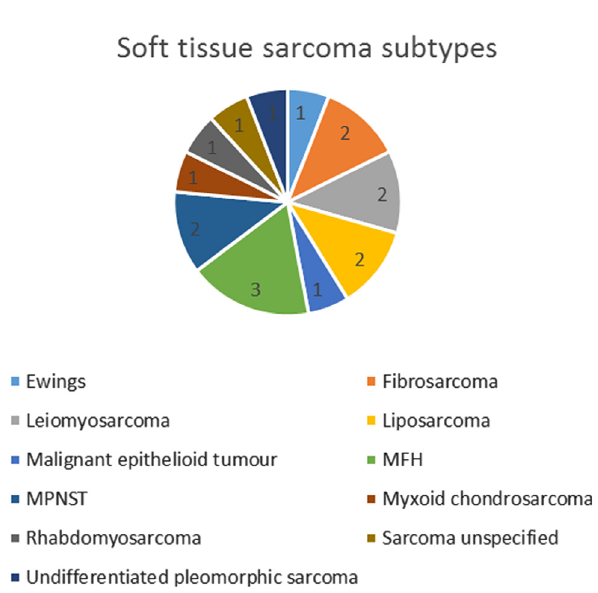
Figure 2. The subtypes of soft tissue sarcomas of the scapula.